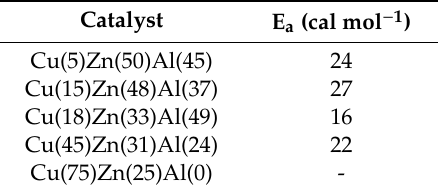
Table 2. Activation energy for the oxy–steam-reforming of methanol process [49].